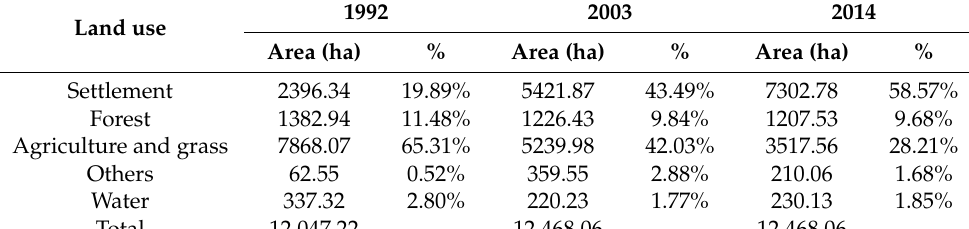
Table 2. Area of each type of land use in Denpasar from 1992 to 2014 and their proportion of total area.